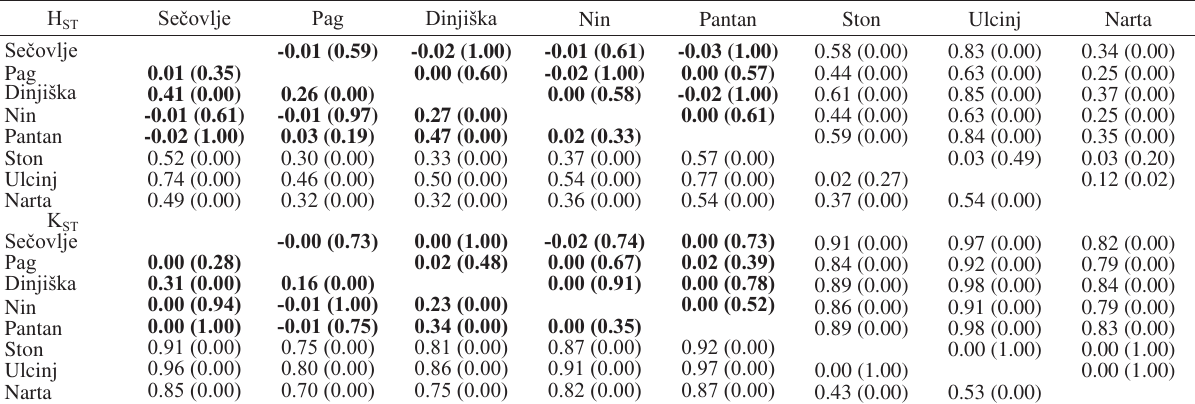
Table 2. – Results of the genetic differentiation tests (H , K ) based on cyt b data set (below diagonal) and mtDNA CR data set (above ST ST diagonal). Numbers in brackets are p-values based on permutation test. P-values lower than 0.02 are considered statistically significant after false discovery rate correction. Values in bold denote populations belonging to the Northern Adriatic group, plain text correspond to the Southern group. H ST Sečovlje Pag